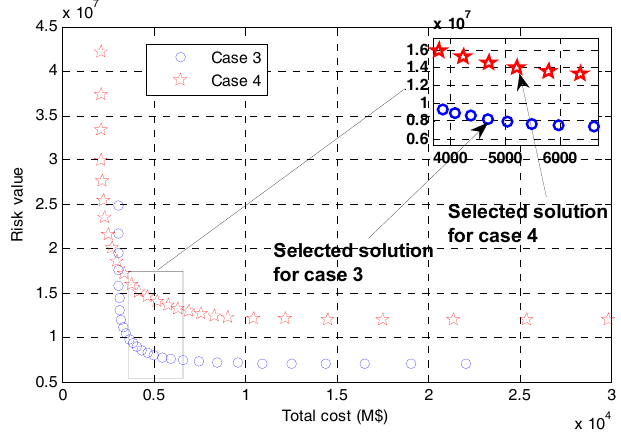
Figure 10. Tradeoffs between cost and risk for cases 3 and 4 for the Polish 2383-bus system.